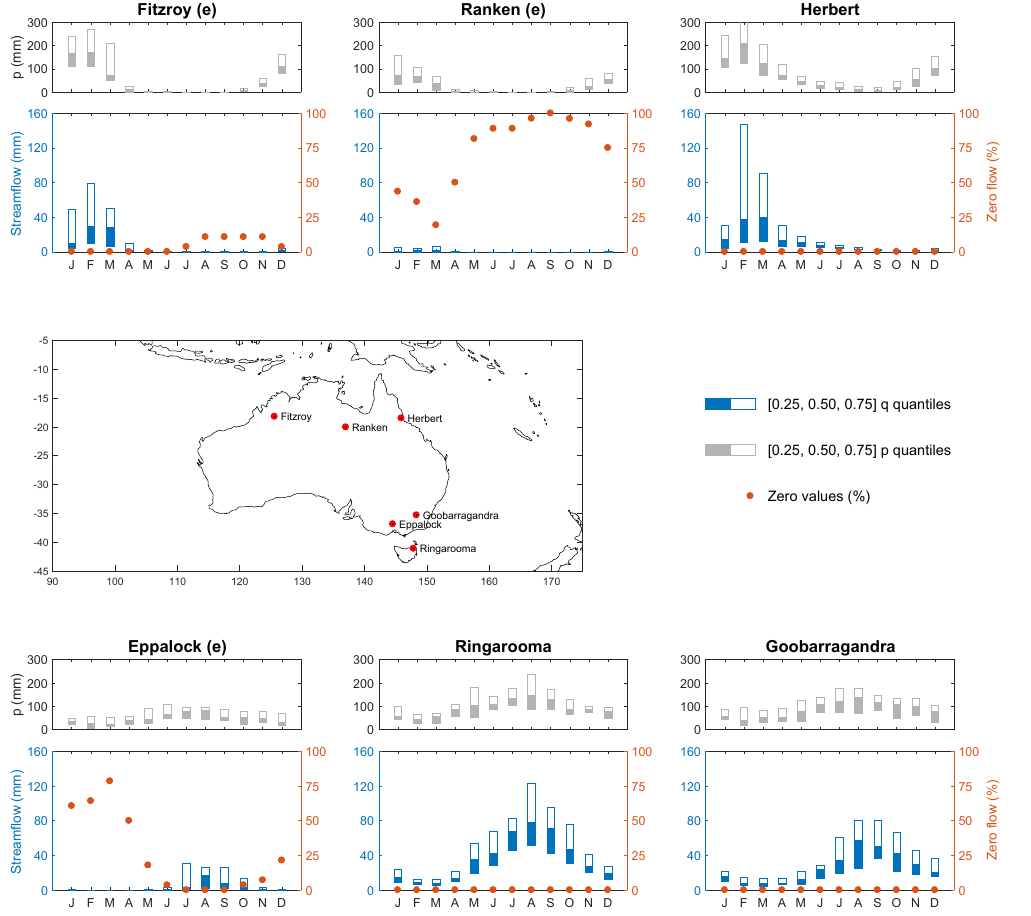
Figure 2. Catchment characteristics of six case study catchments. Ephemeral catchments are denoted by (e). The left axis shows monthly streamflow ( q ) and rainfall ( p ) characteristics, with bars showing the interquartile range and median flows for the period 1982–2009. The right axis shows the proportion of zero flows (orange points) in each month for the period